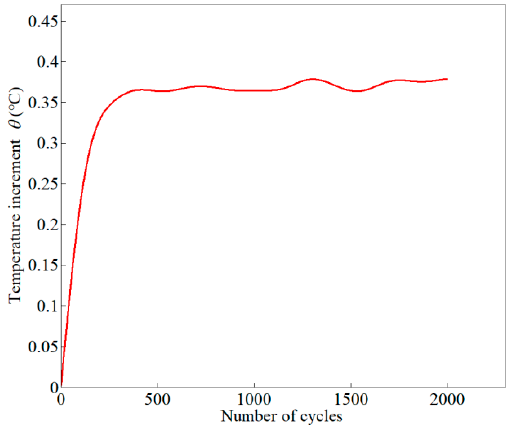
Figure 11. The thermal evolution in 2000 cycles under stress amplitude 240 MPa. Table 5. Predicted results under different stress amplitude.